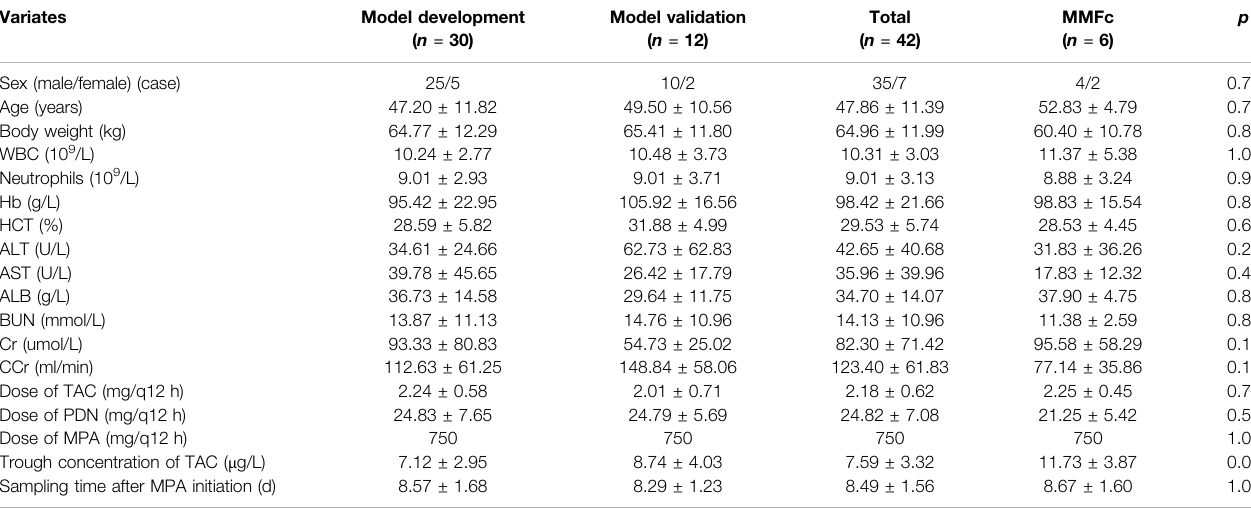
TABLE 1 | The demographic and clinical data of patients in model development and validation groups. Variates Model development ( n =